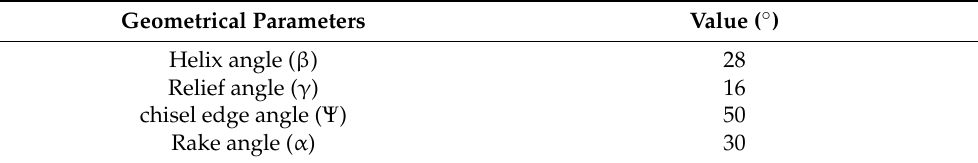
Figure 1. The geometrical details of cutting tool. Table 2. The geometrical parameters of twist drill.